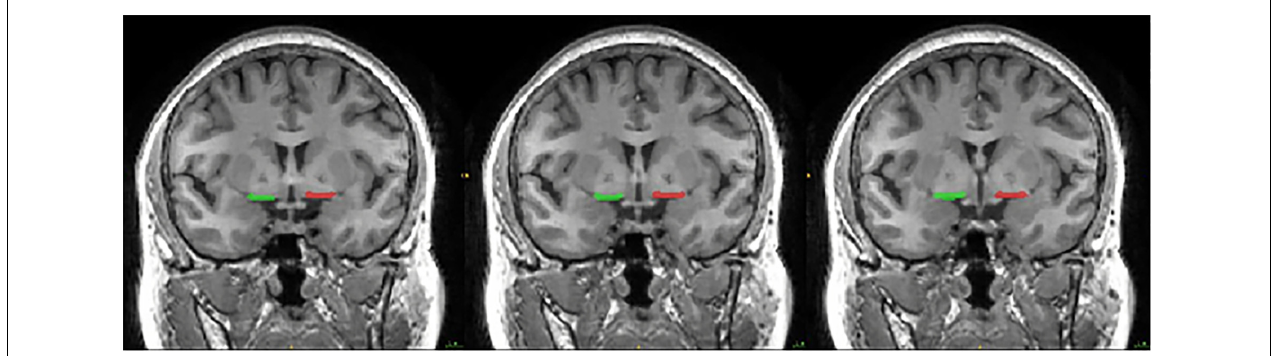
FIGURE 1 | Coronal slice of the MRI image showing the location of the substantia innominate (SI) used in the seed-based resting-state functional connectivity (rsFC) analysis. The SI was drawn at three consecutive gapless 1.2 mm-thick slices on T1-weighted coronal images reformatted to be perpendicular to the anterior commissure (AC)-posterior commissure (PC) line. The three consecutive sections analyzed were located at the level of the crossing of the AC, the level where the AC might be uncrossed, and the level of the emergence of the AC from the temporal lobe. The boundaries of the SI were as follows: the dorsal border was the ventral aspect of the globus pallidus, the ventral border was the base of the brain containing the anterior perforated space, the medial border was operationally defined by a vertical line extending from the ventrolateral border of the bed nucleus of the stria terminalis to the base of the brain, and the lateral border extended to the medial aspect of the